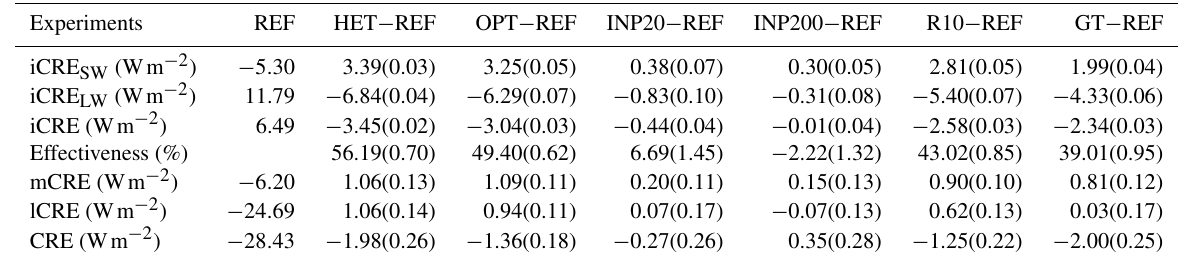
Table 2. Global annual mean cloud radiative effect from all experiments ∗ . The corresponding standard deviations calculated from the differ- ence of each year for 10 years are shown in brackets.